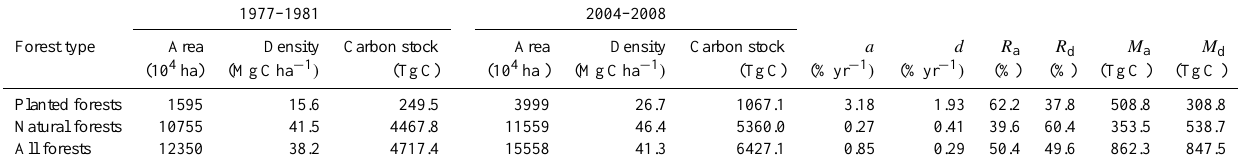
Table 1. Summary of forest variables for planted, natural, and all forests between the forest inventory periods of 1977–1981 and 2004–2008.